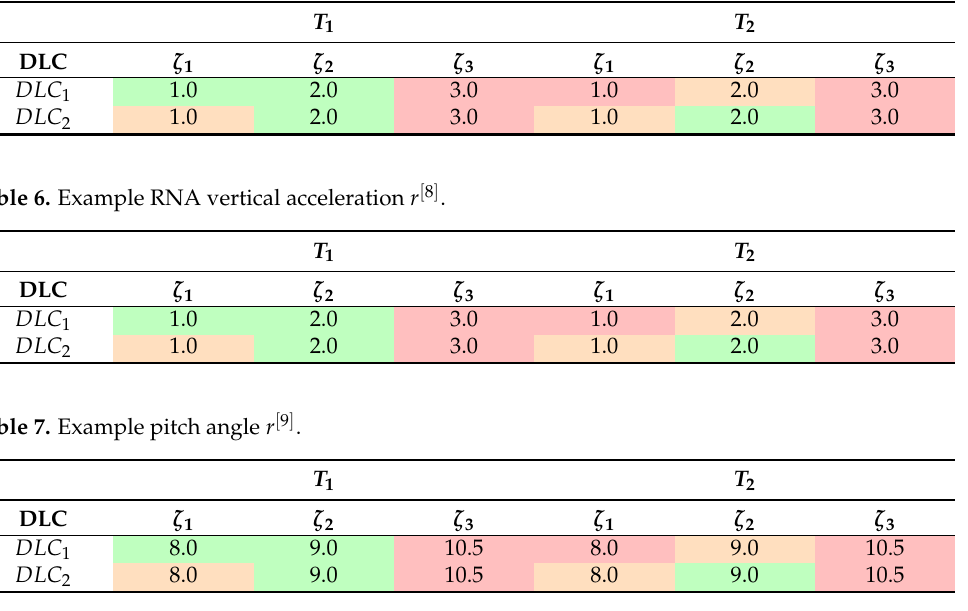
Table 5. Example RNA horizontal acceleration r [ 7 ] .